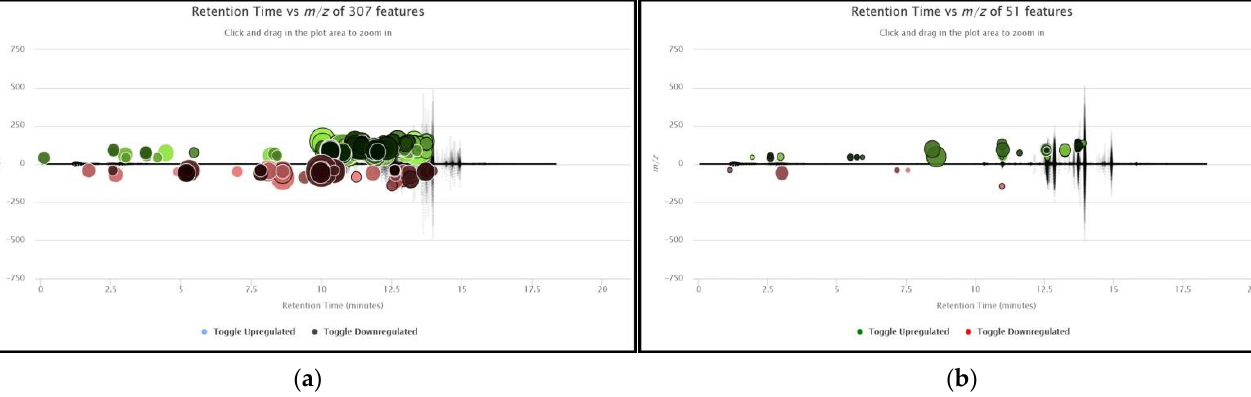
Figure 1. Cloud plots with results of pairwise XCMS analysis between ( a ) Ca+ vs. HC. Detection settings: p -value < 0.01, fold change > 2, m / z range: 0 – 140, retention range: 0 – 14 min, max intensity > 10,000 and ( b ) Ca+ vs. Ca − characteristics (ion). Detection settings: p -value <0.05, fold change > 1.1, m / z range: 0 – 140, retention range: 0 – 14 min, max intensity > 10,000.